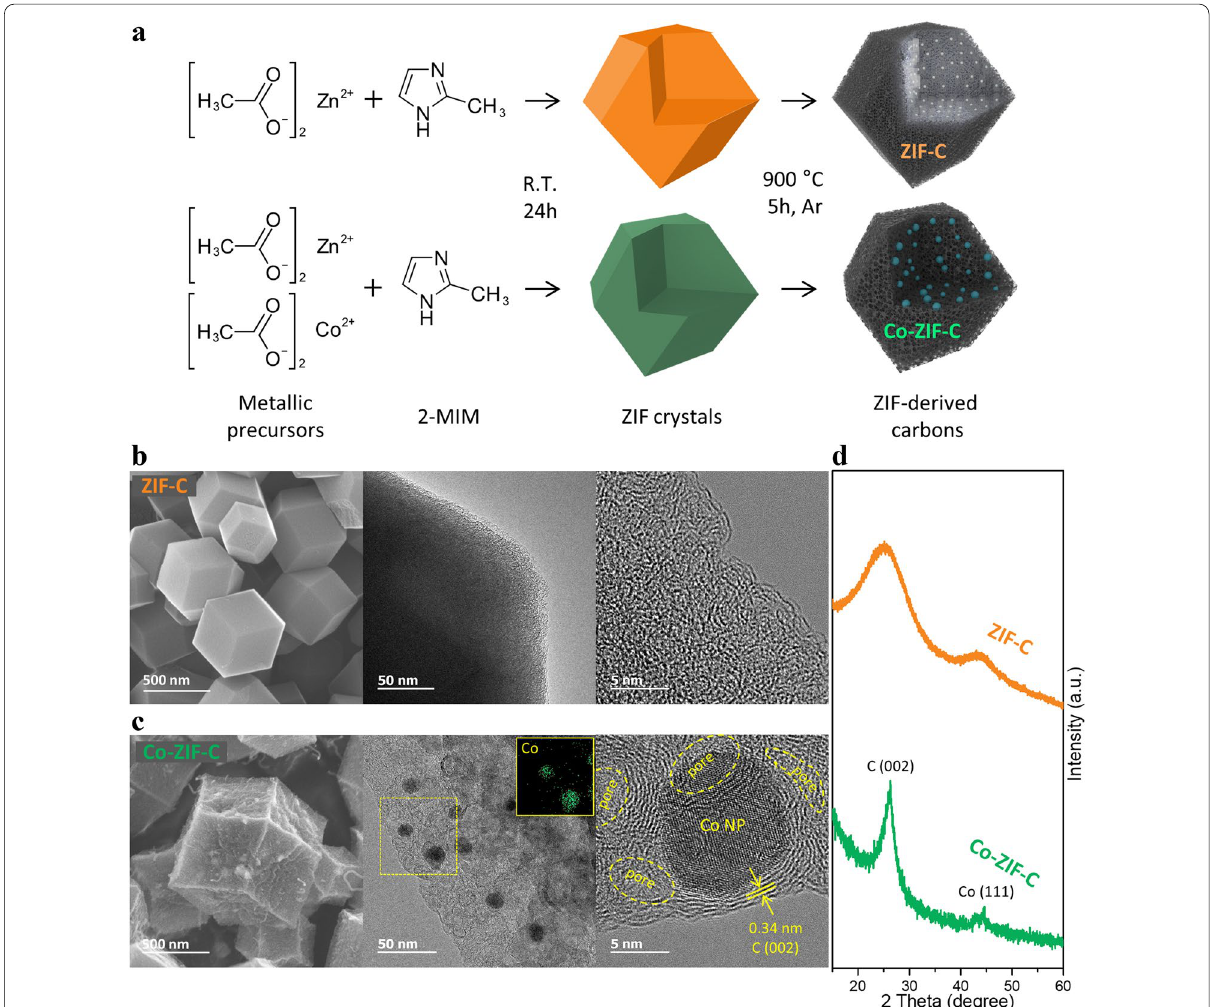
Fig. 1 a Schematic illustration of the synthesis of ZIF‑derived carbons, FESEM and TEM images of ( b ) ZIF‑C and c Co‑ZIF‑C; d XRD patterns of ZIF‑C and